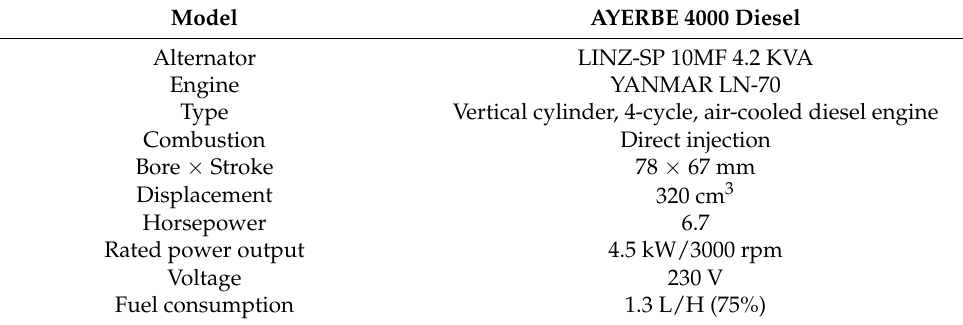
Table 1. Technical specifications of the diesel engine electric generator set.